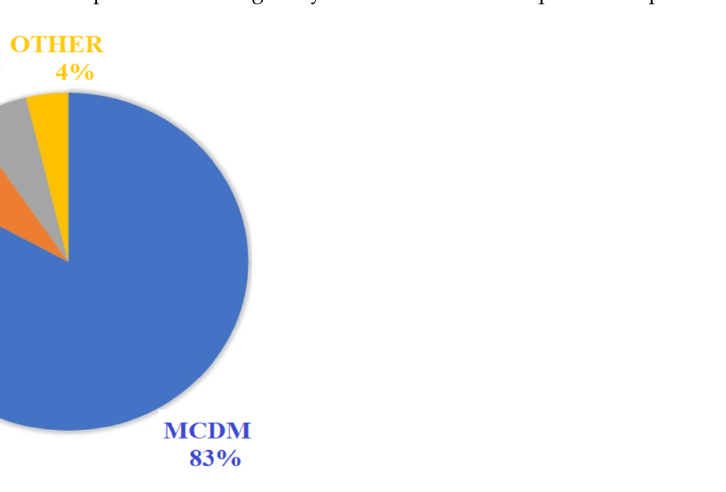
Figure 2. Sustainable transportation articles using decision-making techniques for the period 2000–2022.